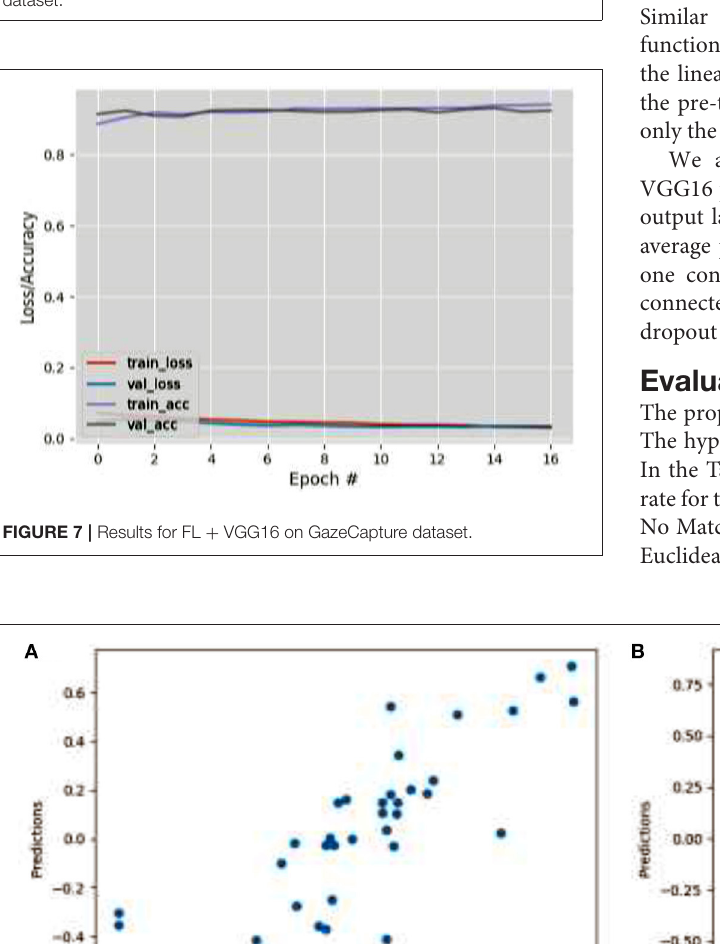
Frontiers in Artificial Intelligence |